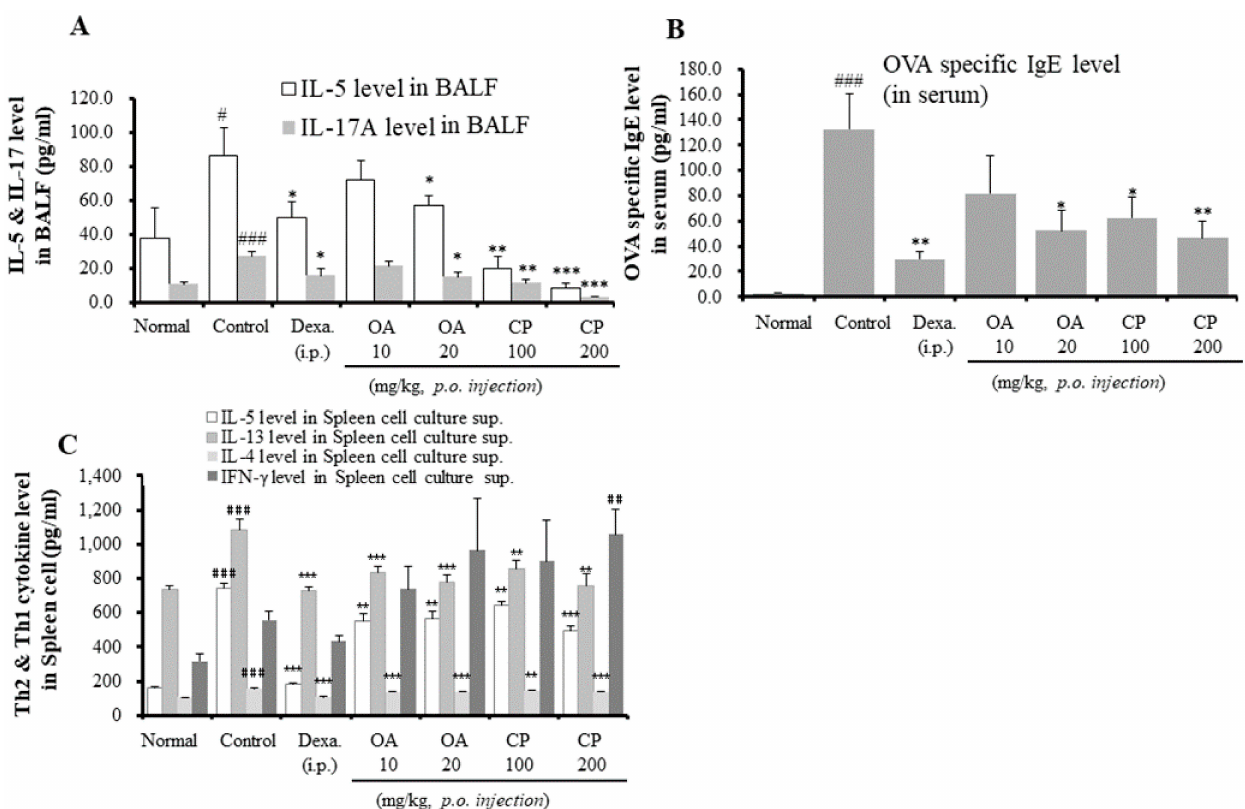
Figure 3. The effects of OA, CP, and Dexa on Th2 cytokine (IL-5) and IL-17A ( A ) in BALF; the levels of OVA specific IgE ( B ) in serum; and Th2/Th1 cytokines (IL-4, IL-5, IL-13, and interferon (IFN)- γ ) ( C ). Each point represents the mean ± SEM values for 6 mice. * p < 0.05, ** p < 0.01, and *** p < 0.001 for the OVA control group versus the experimental group comparisons. # p < 0.05, ## p < 0.01, and ### p < 0.001 for the OVA control group versus the normal group comparison. Normal, Normal BALB/c mice; Control, OVA inhalation plus vehicle; Dexa., OVA inhalation plus dexamethasone, 3 mg/kg; OA, OVA inhalation plus OA, 10 or 20 mg/kg; CP, OVA inhalation plus CP (100 or 200